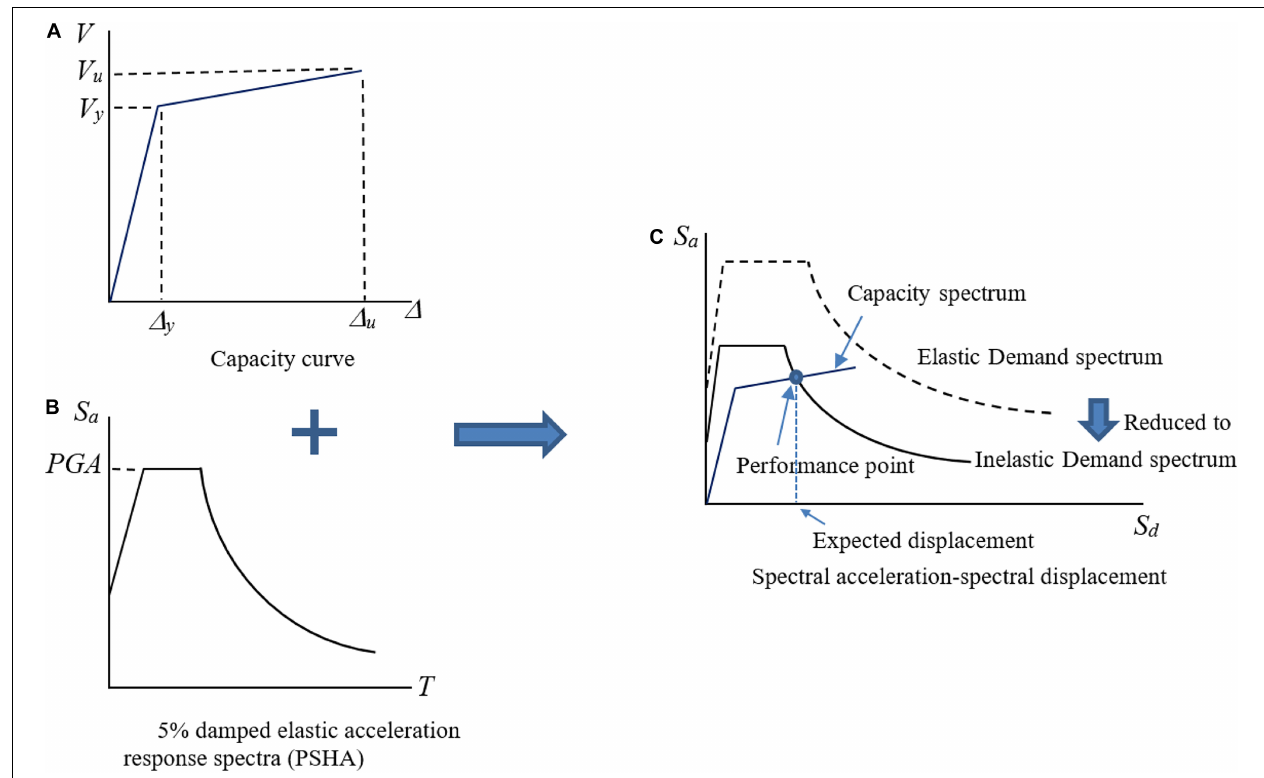
FIGURE 3 | Performance point determination (FEMA, 2003). (A) Capacity curve; (B) 5% damped elastic acceleration response spectra (PSHA); (C) spectral acceleration-spectral displacement.